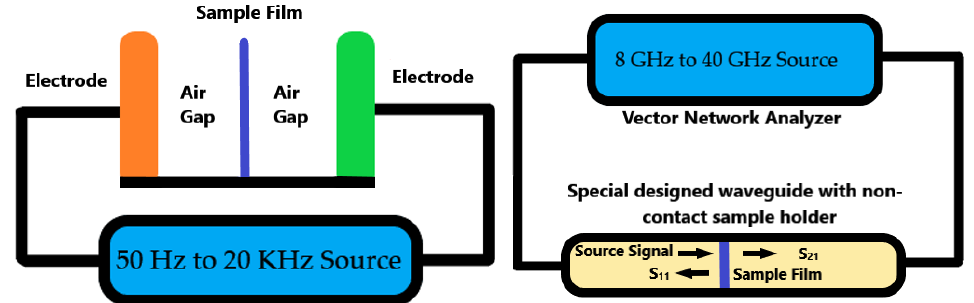
Figure 3. The Simplified diagram for non-contact measurement: air-gap capacitor technique for 50 Hz~20 KHz ( left ); in-waveguide technique for 8 GHz to 40 GHz ( right ).